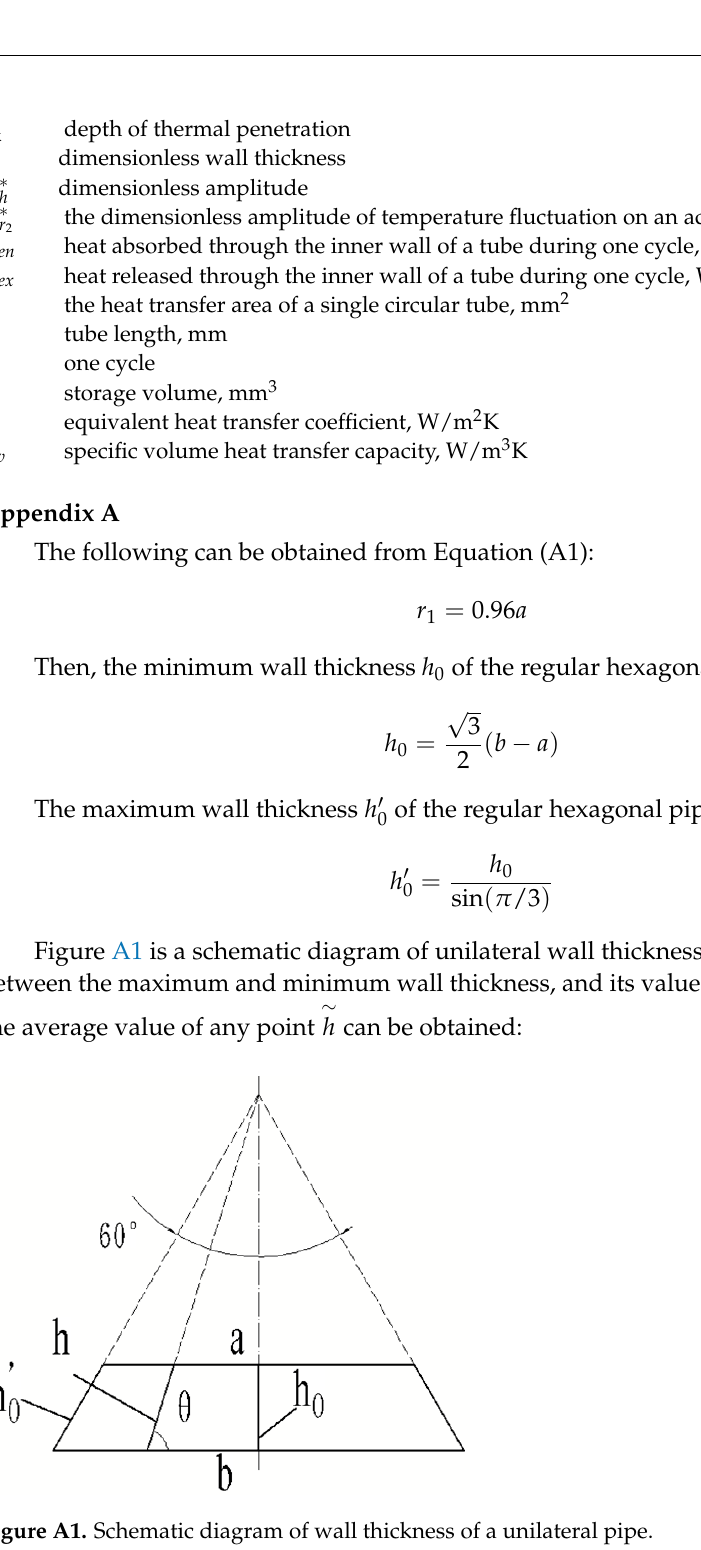
Figure A1. Schematic diagram of wall thickness of a unilateral pipe.